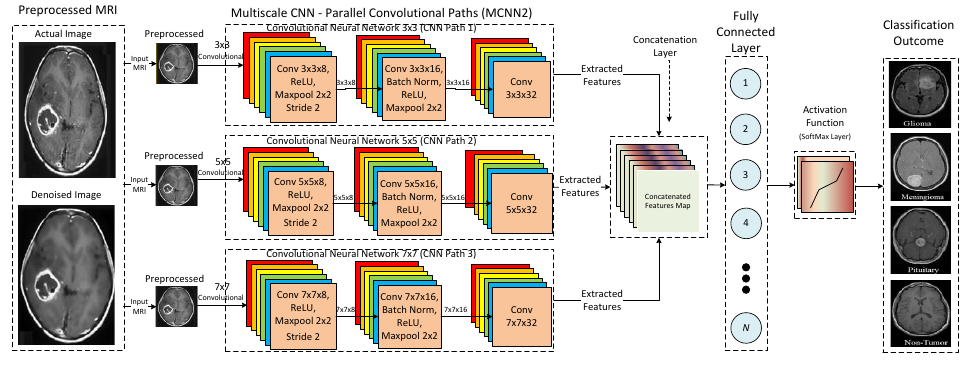
Figure 10. Detailed architecture of the proposed